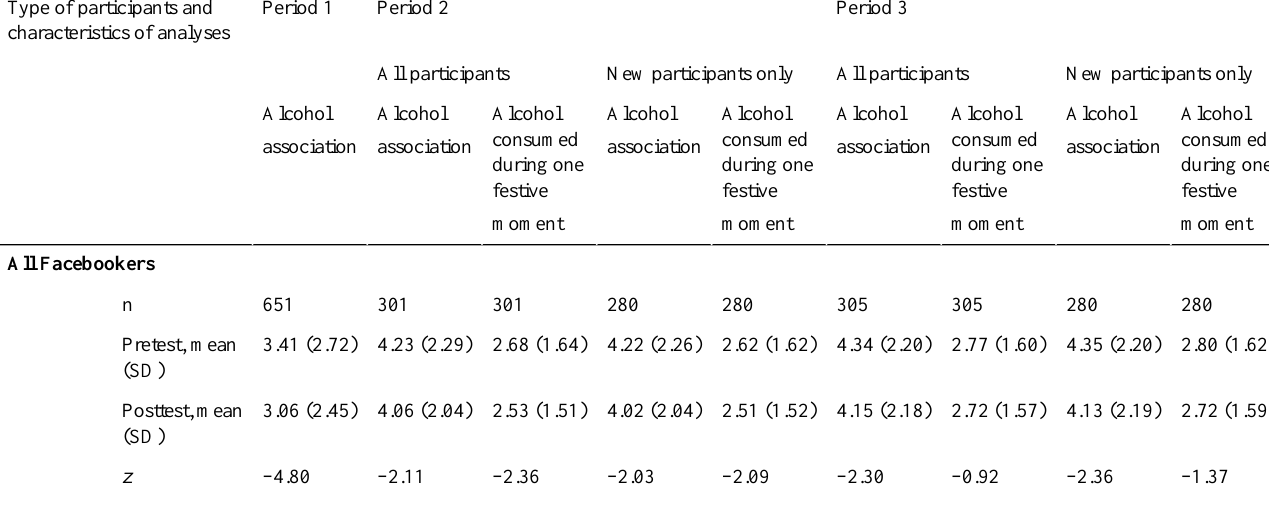
Table 1. Comparison between pre- and posttest scores for association of alcohol and festive moments for each group during the 3 test periods and the mean number of glasses of alcohol consumed during one festive moment for periods 2 and